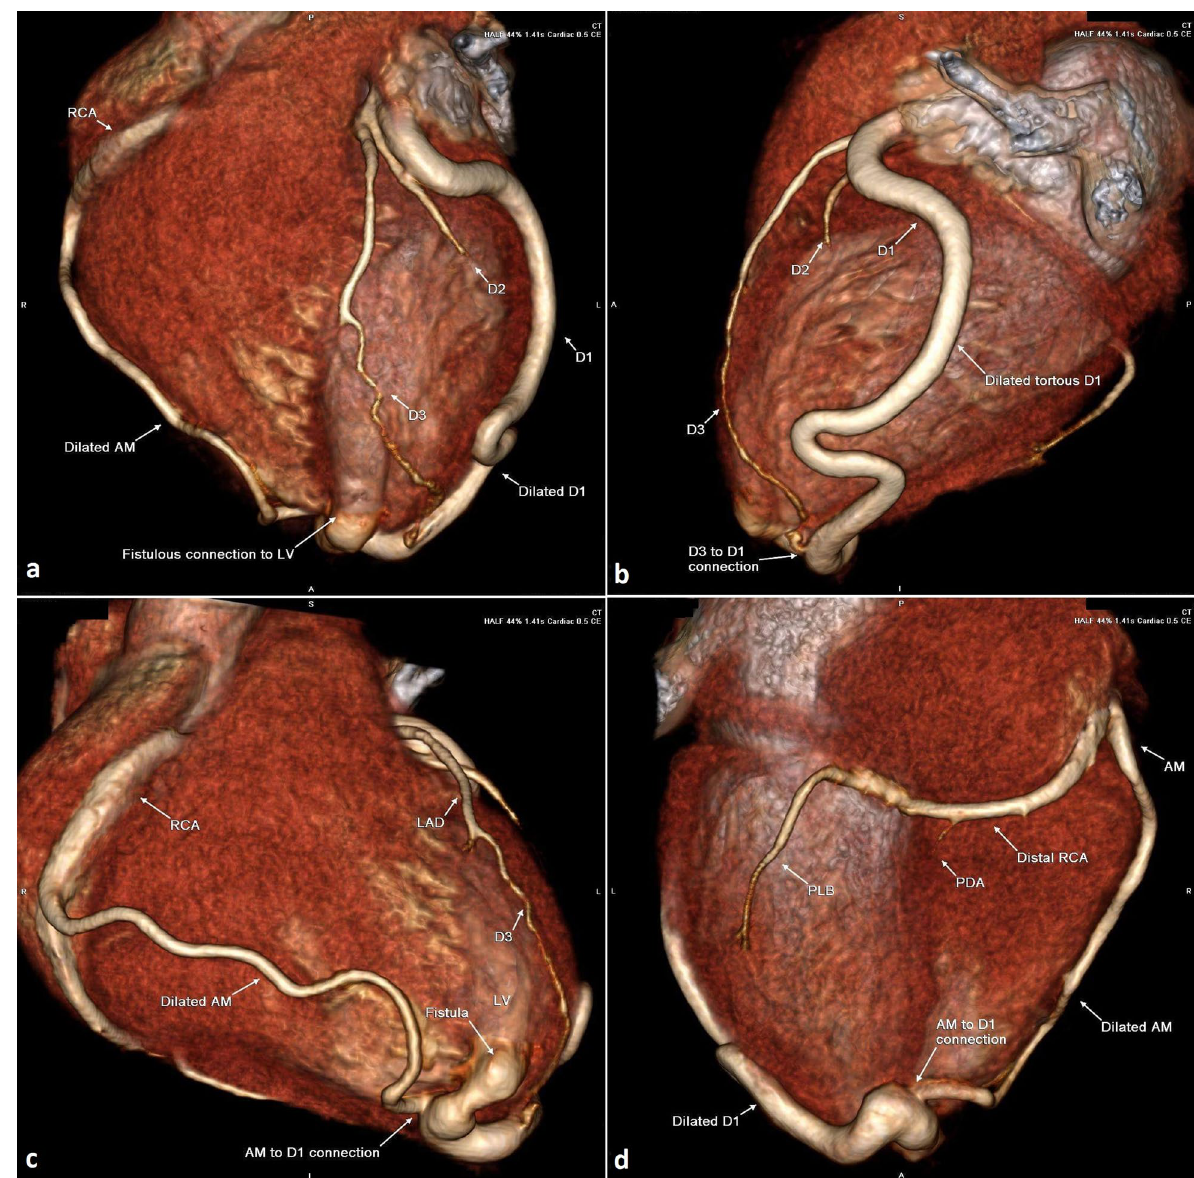
Fig. 1 Large first diagonal branch coronary artery fistula with LV apex in 20-year-old male with typical chest pain. Semitransparent 3D volume rendered images show ectatic tortuous first diagonal branch of LAD that runs over anterior and lateral walls of LV and ends by forming large fistulous connection with LV apex ( a , b ). Ectatic RV acute marginal branch is evident due to intercoronary communication with first diagonal branch just proximal to its fistulous connection with LV apex ( c , d